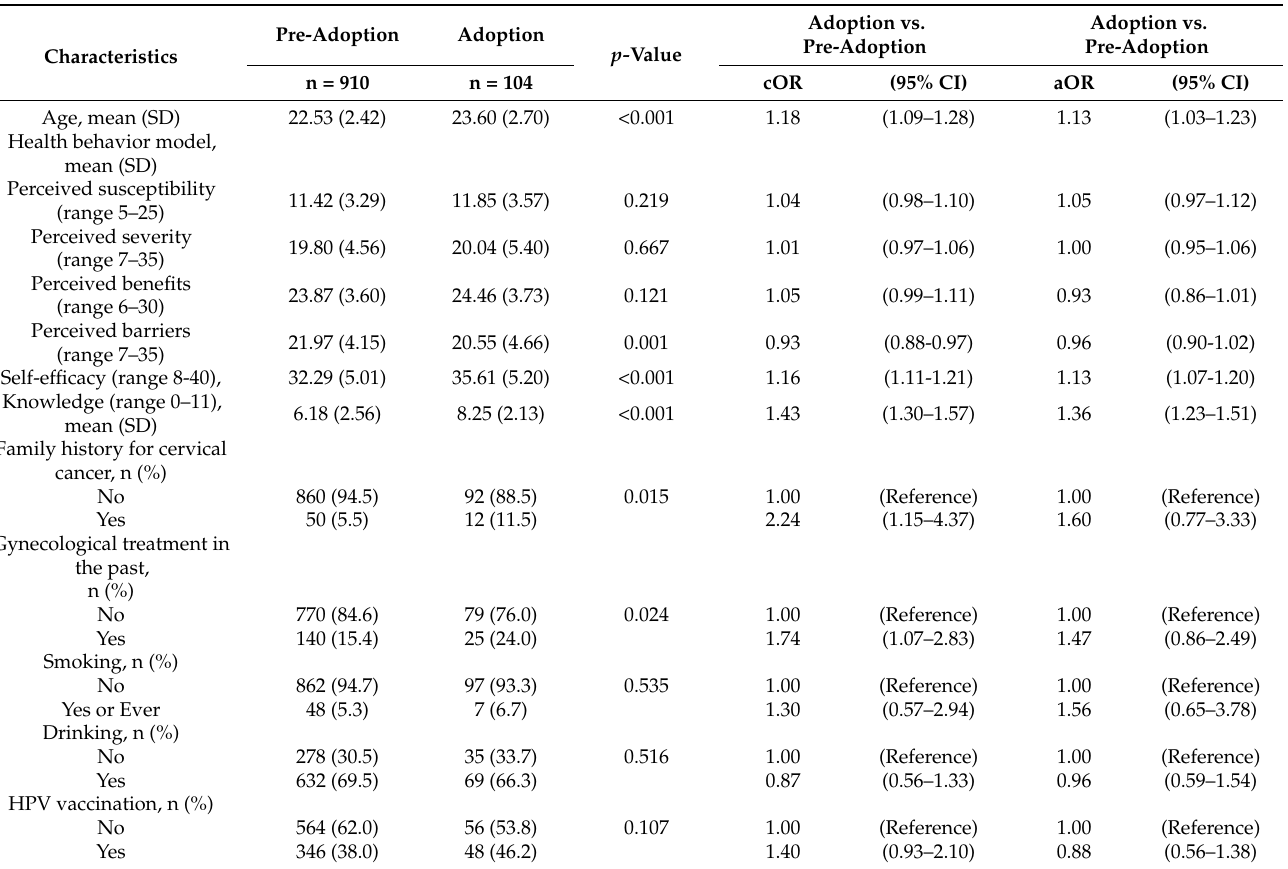
Table 2. Associated factors related to decisional stages of cervical screening adoption based on PAPM stage.